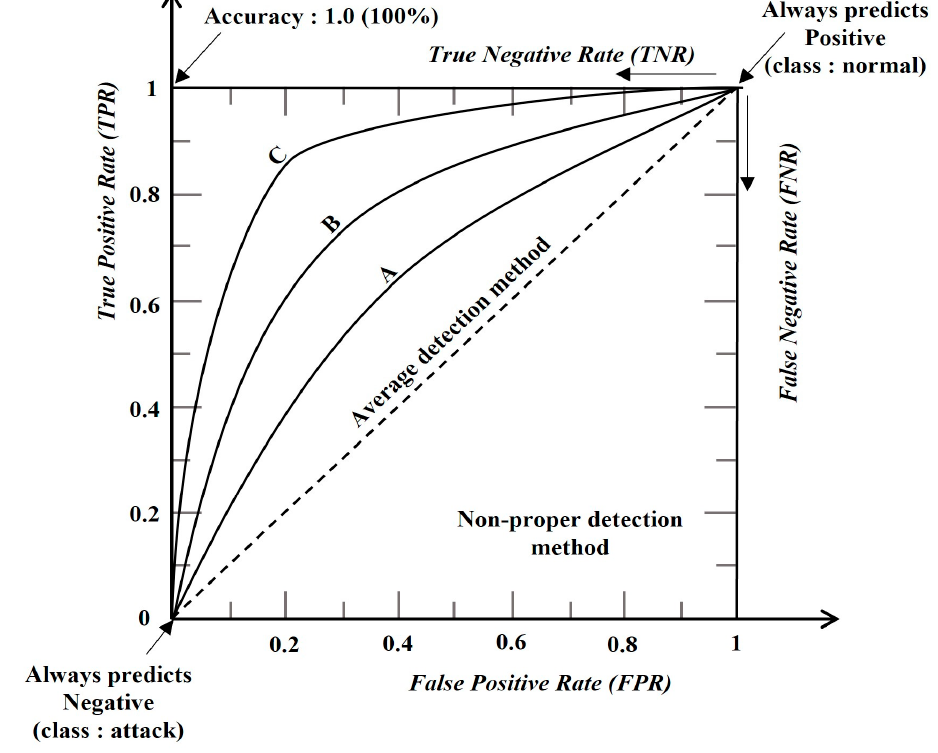
Figure 5. ROC curve.